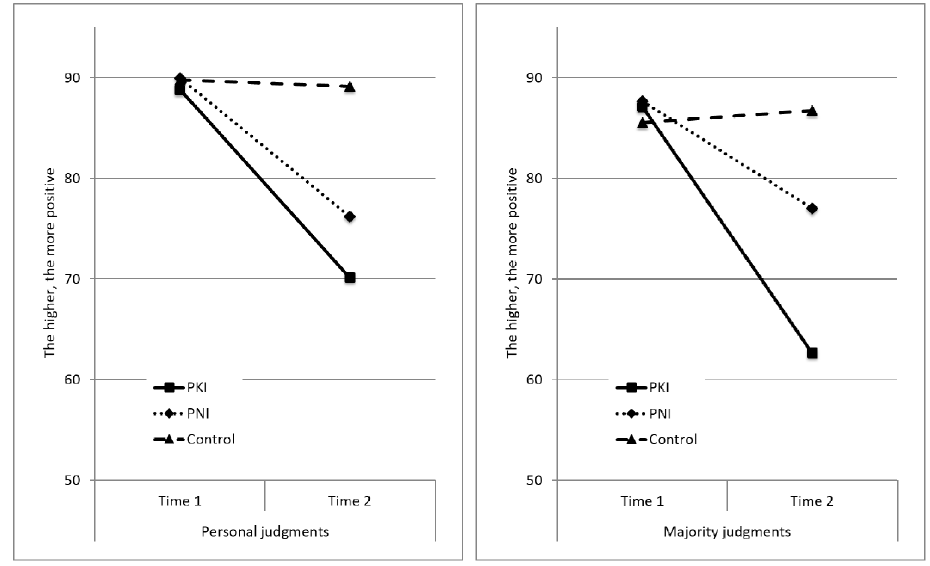
Figure 2. Mean estimates of positive judgments in Study